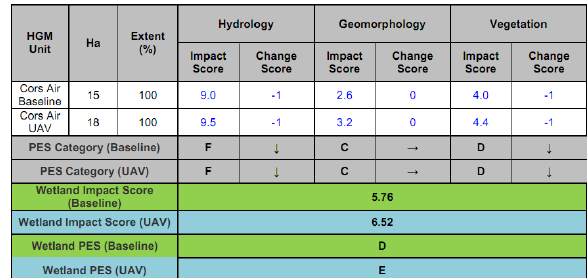
Table 2. Summary of present wetland health based on the Wet- Health assessment (baseline and